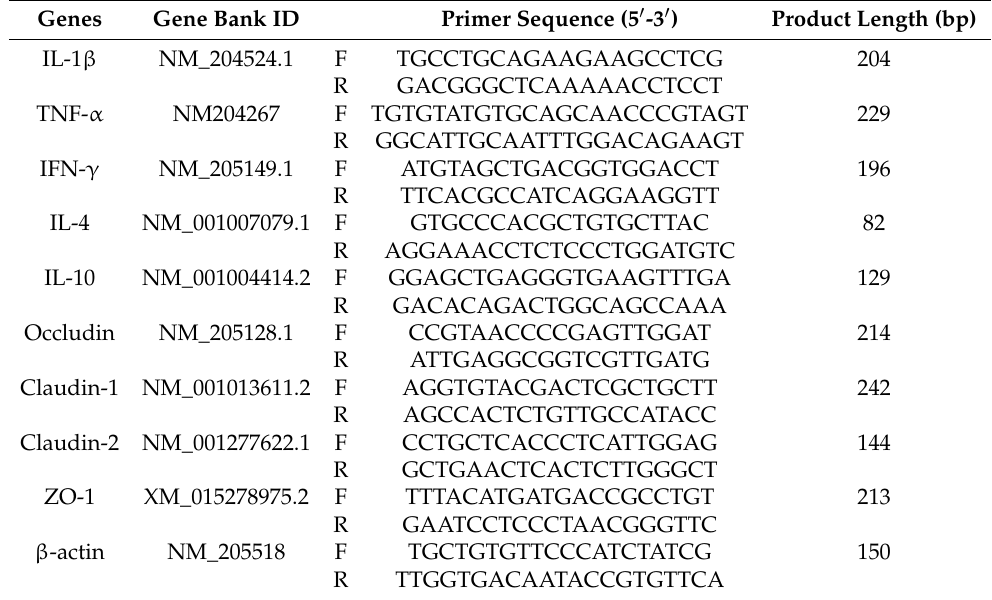
Table 2. Sequences for real-time PCR